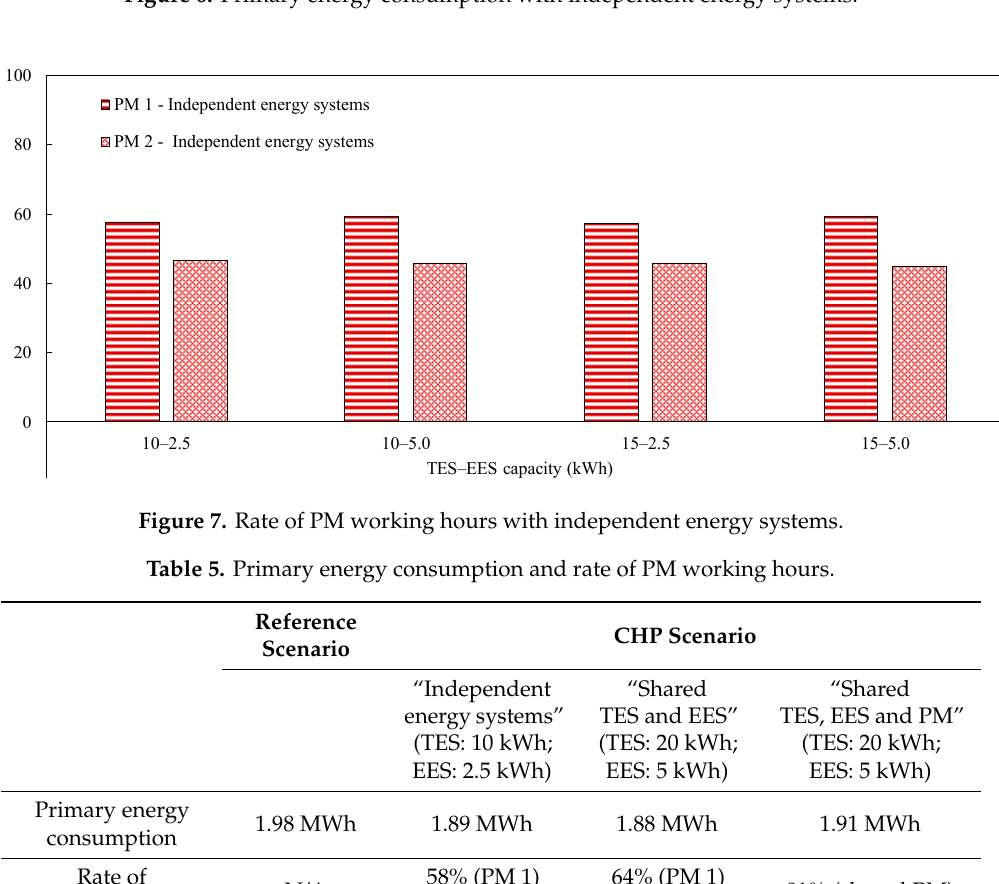
Figure 6. Primary energy consumption with independent energy systems.